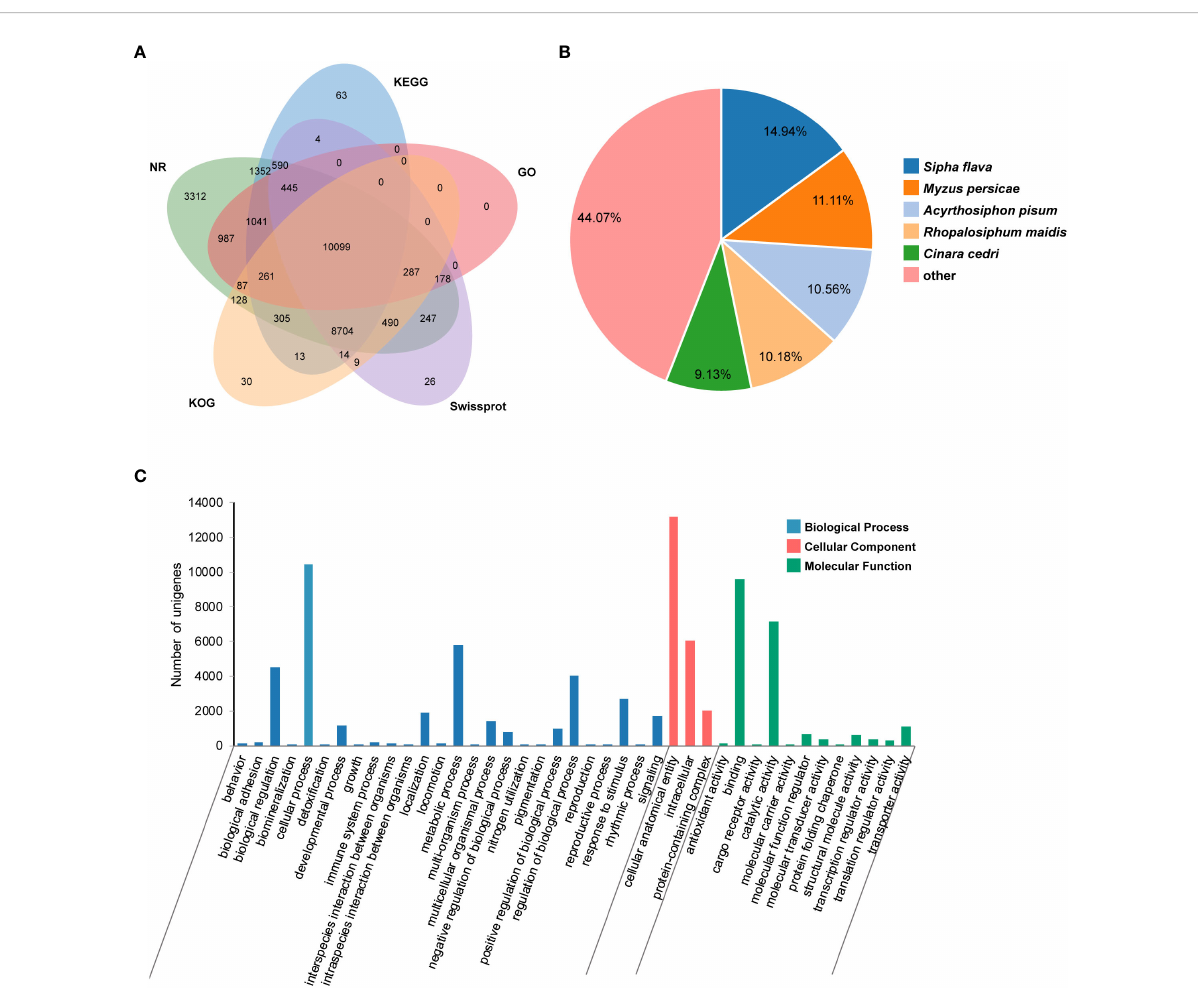
FIGURE 1 Transcriptomic annotation for Pseudoregma bambucicola salivary glands. (A) Venn diagram of annotated results via different databases. (B) Species distribution of annotation results in Nr database. Only the top fi ve closely matched species are shown. (C) Gene Ontology classi fi cation of Pseudoregma bambucicola salivary gland